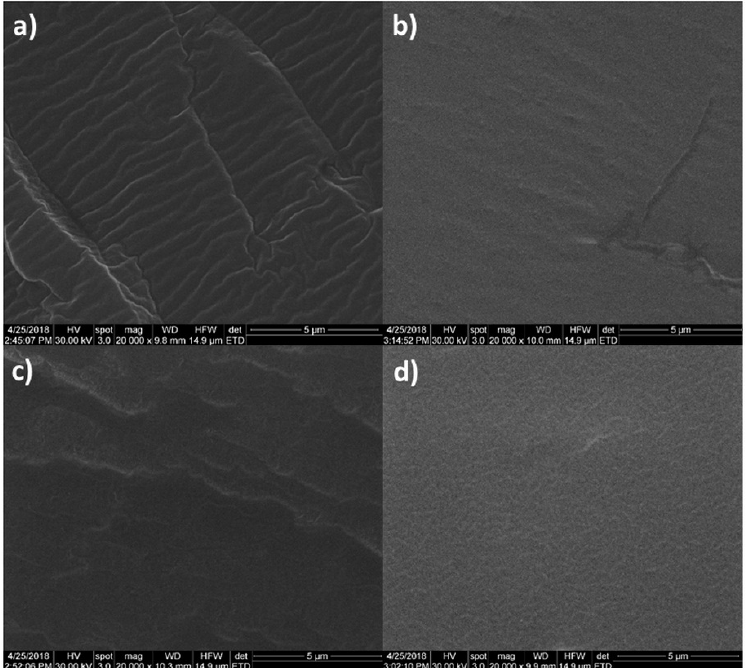
Figure 8. Morphological characterization by SEM for: a ) the polyurea matrix and b ) the nanocom- posites PUG , c ) PUM and d ) PUMG . posites PUG, ( c ) PUM and ( d ) PUMG.